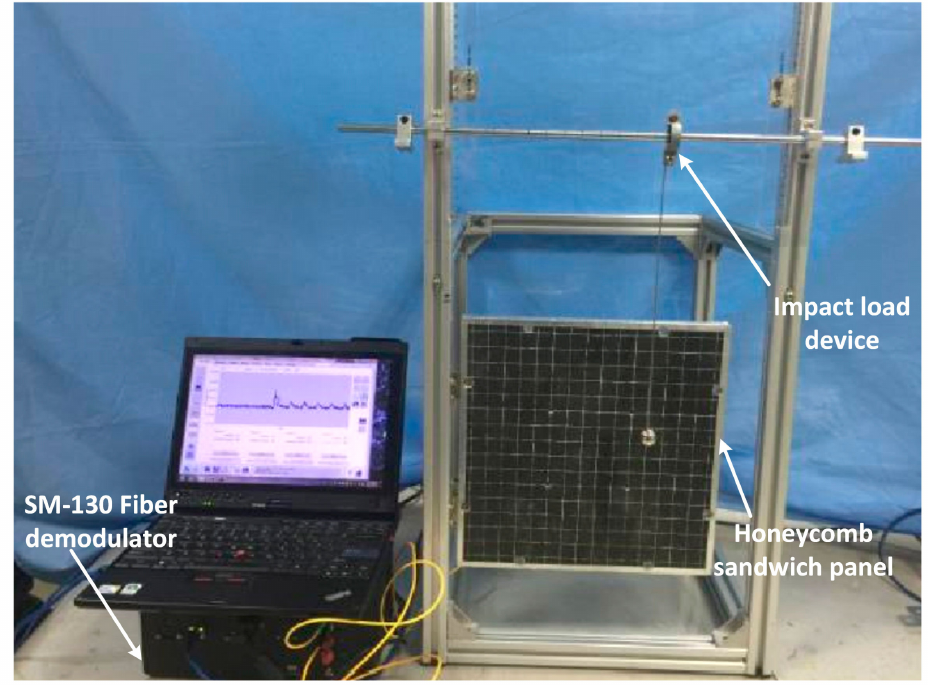
Figure 3. Photo of the measurement system and loading